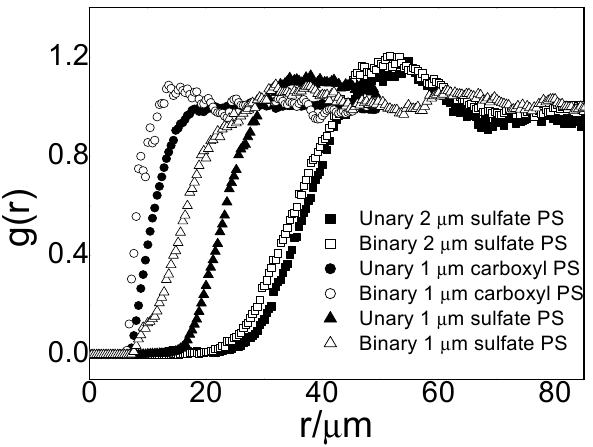
Figure 2. g(r) of large particles in presence and absence of small particles: large particles moved closer to each other in the binary system (hollow symbols) than in the unary system (solid symbols); ■ 2 µm sulfate polystyrene (PS) unary system; □ 2 µm sulfate PS + 0.21 µm of sulfate PS binary system; ● 1 µm carboxyl PS unary system; ○ 1 µm carboxyl PS + 0.21 µm sulfate PS binary system; ▲ 1 µm sulfate PS unary system; ∆ 1 µm sulfate PS + 0.21 µm of sulfate PS binary system.